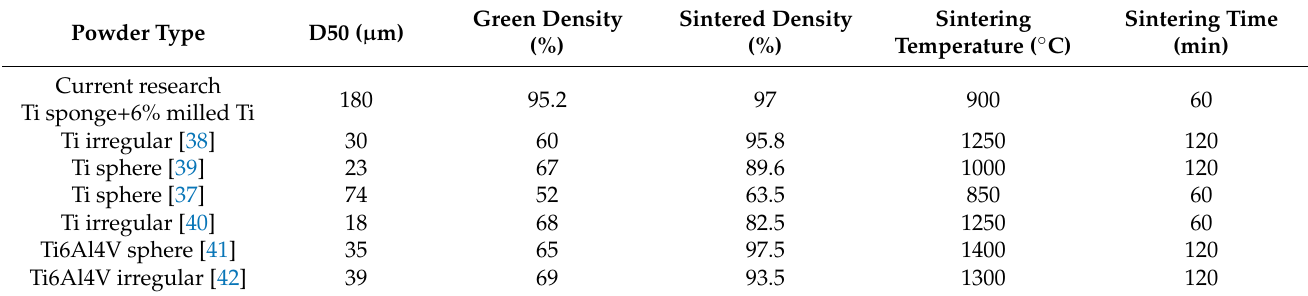
Table 3. Density values of different titanium and Ti alloy sintered at different conditions.